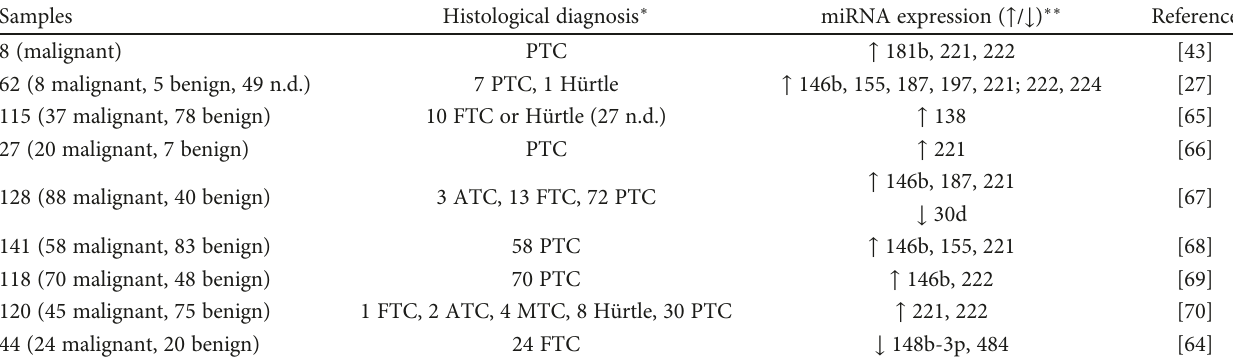
Table 2: Studies of miRNAs in FNAB